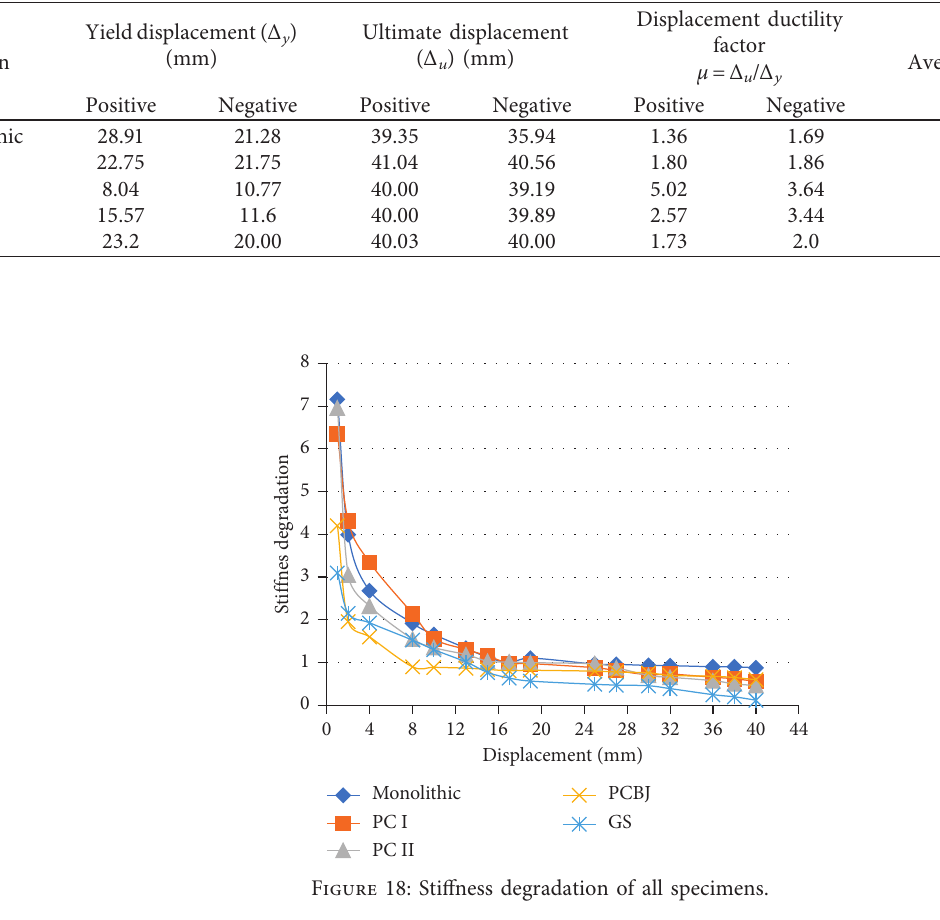
Table 5: Displacement ductility and ductility factor of all specimens.